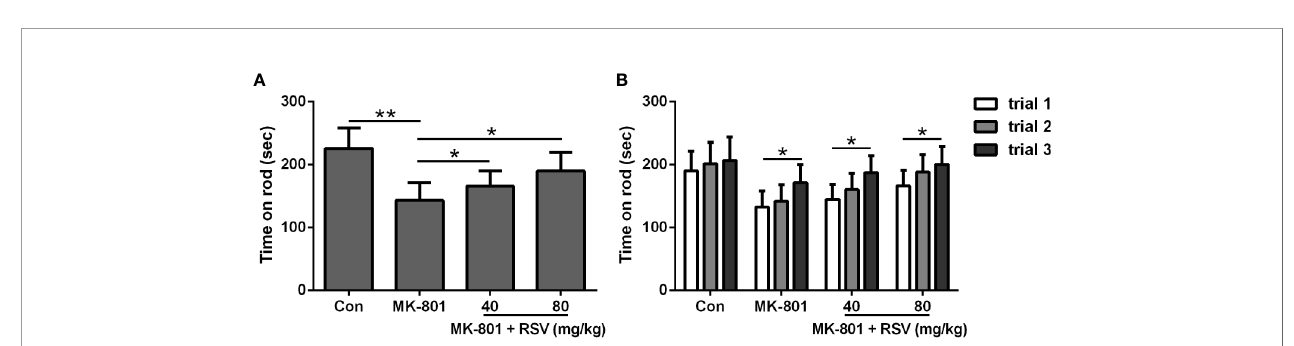
FIGURE 4 | Effect of RSV on MK-801-induced de fi cits in the rotarod test. Mean latency of three trials of staying on the rod (A) and falling time in three successive trials (B) were compared. n = 10 in each group. Data were presented as mean ± SD. F ratios: (A) 12.28 (3.00, 17.91). *p < 0.05, **p < 0.01 between the indicated groups.